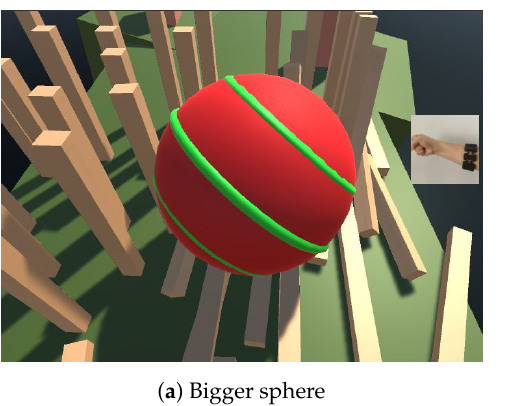
Figure 3. Three-dimensional game.